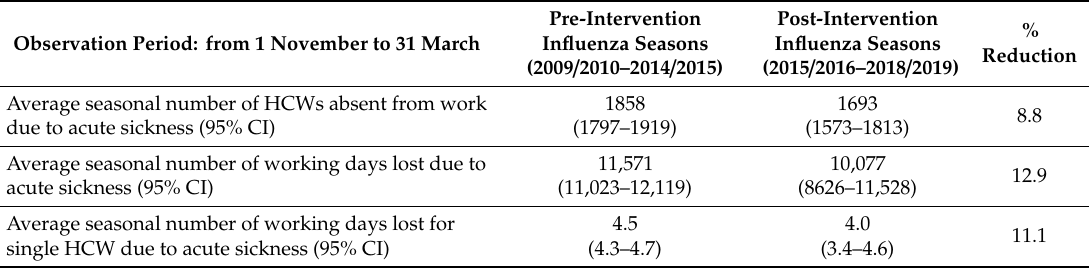
Table 3. Data on absenteeism from work due to acute sickness during pre and post intervention influenza seasons among HCWs of the UH of Palermo.